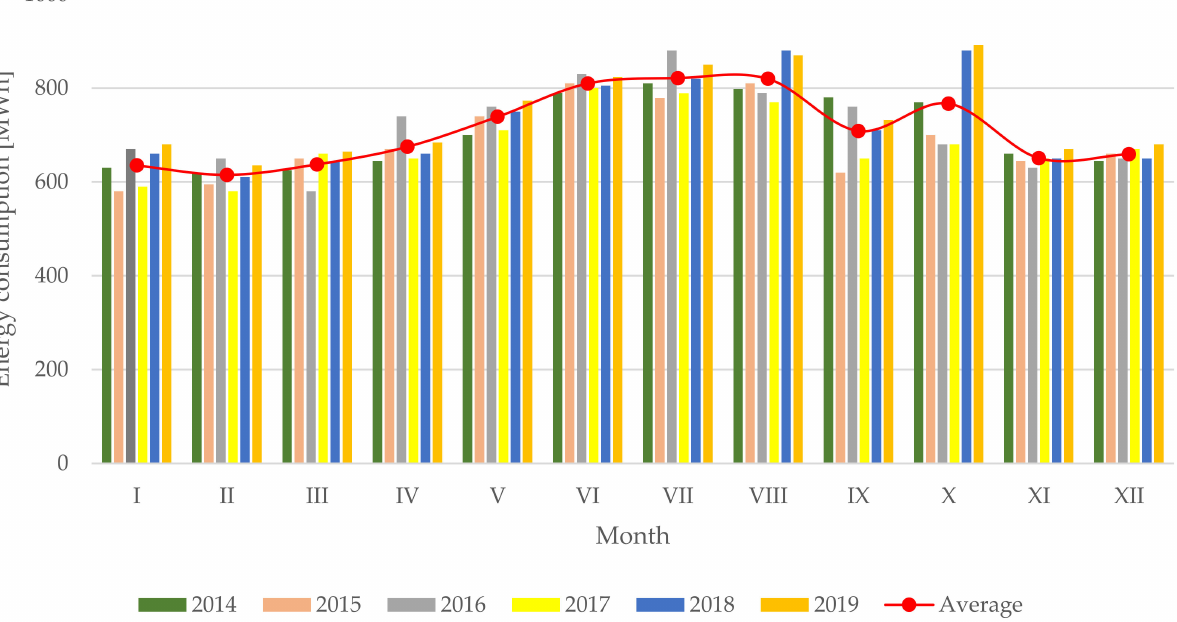
Figure 7. Measured electricity consumption in a hotel facility in